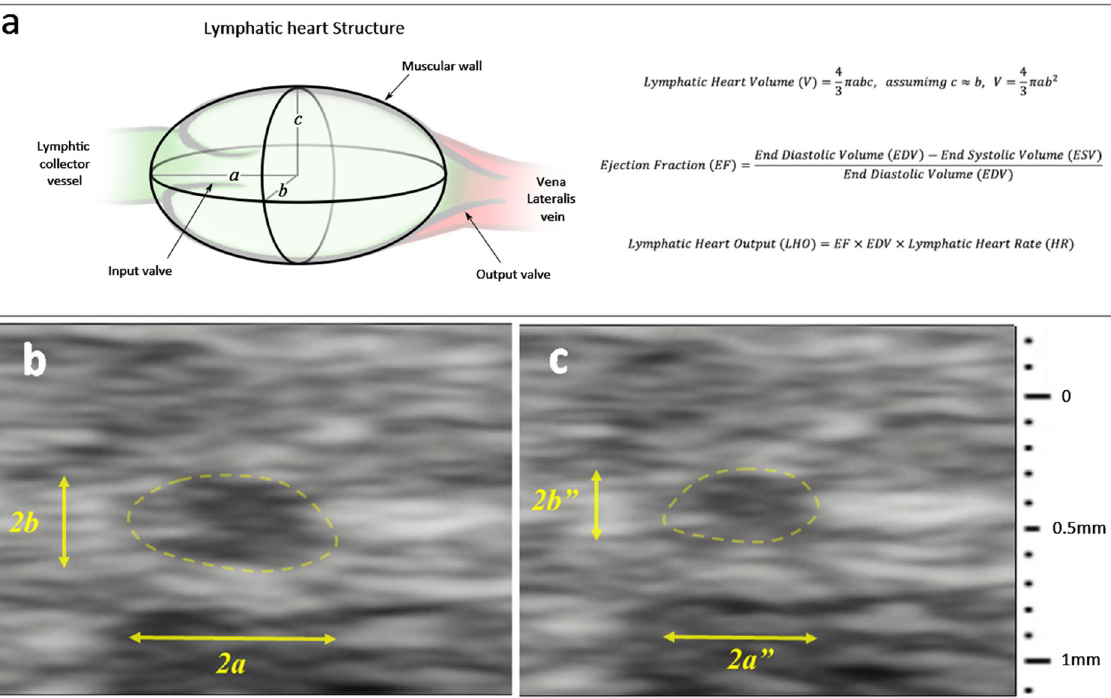
Figure 2. Ultra-high frequency ultrasound-based calculation of the newt lymphatic heart cardiac output. ( a ) The lymphatic heart (LH) structure consists of a single muscular chamber receiving lymphatic fluid from the lymphatic collectors and pumping this fluid into the vena lateralis vein. The LH has one input valve and one output valve that prevent backflow of blood. Computer 3D volume reconstruction showed the newt lymphatic heart shape conformed best to an ellipsoid-like shape with a slightly pointed output end and flattened input end, therefore, the ejection fraction (EF) was calculated using an ellipsoid mathematical model based on 2D ultra- high frequency ultrasound measurement of the LH end diastolic volume (EDV) ( b ) and end systolic volume ( c ), and the LH rate. The mean EF was 60.40% (SD 12.94), EDV 0.026 mm 3 (SD 0.008) and the mean lymphatic heart rate was 117.04 bpm (SD 23.12), giving a LH cardiac output (LHO) of 1.838 mm 3 /min for each LH and a combined total of 58.816 mm 3 /min for all 16